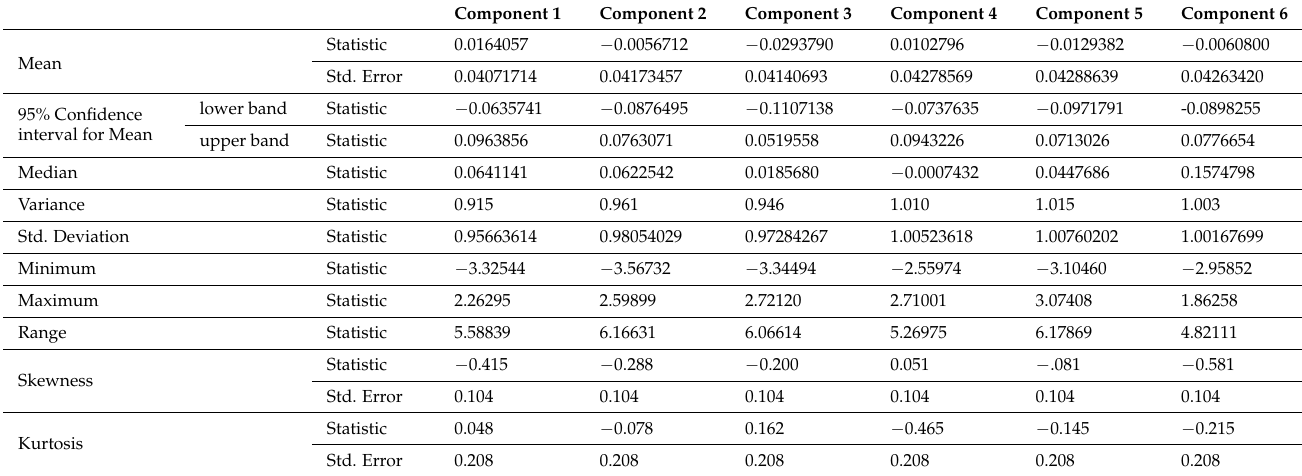
Table 5. Descriptive statistics of the components.